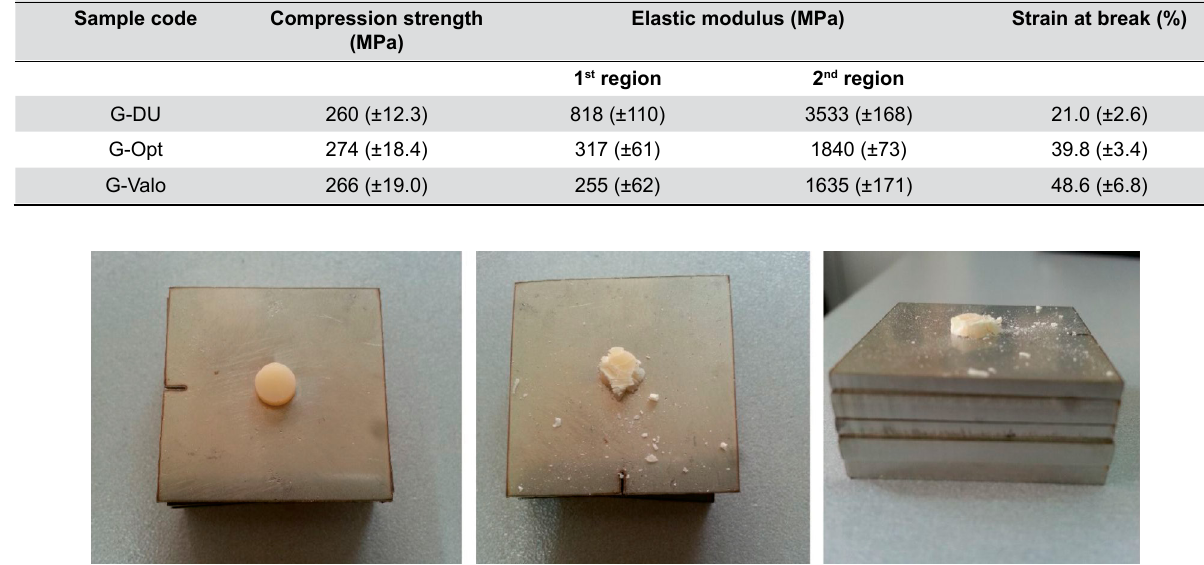
Figure 8- Compression test specimen before and after test Table 3- Comparison of flexural strength between giomer cured with different light-curing units Sample